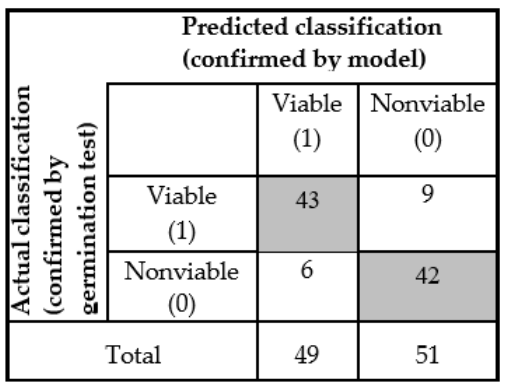
Figure 7. Confusion matrix of test data set measured from general model.